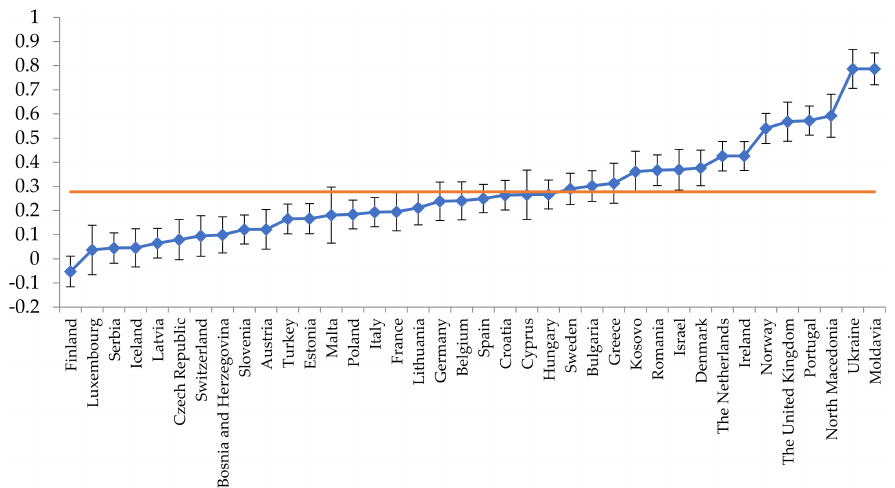
Figure 1. A caterpillar plot for the outcome variable on outreach work per